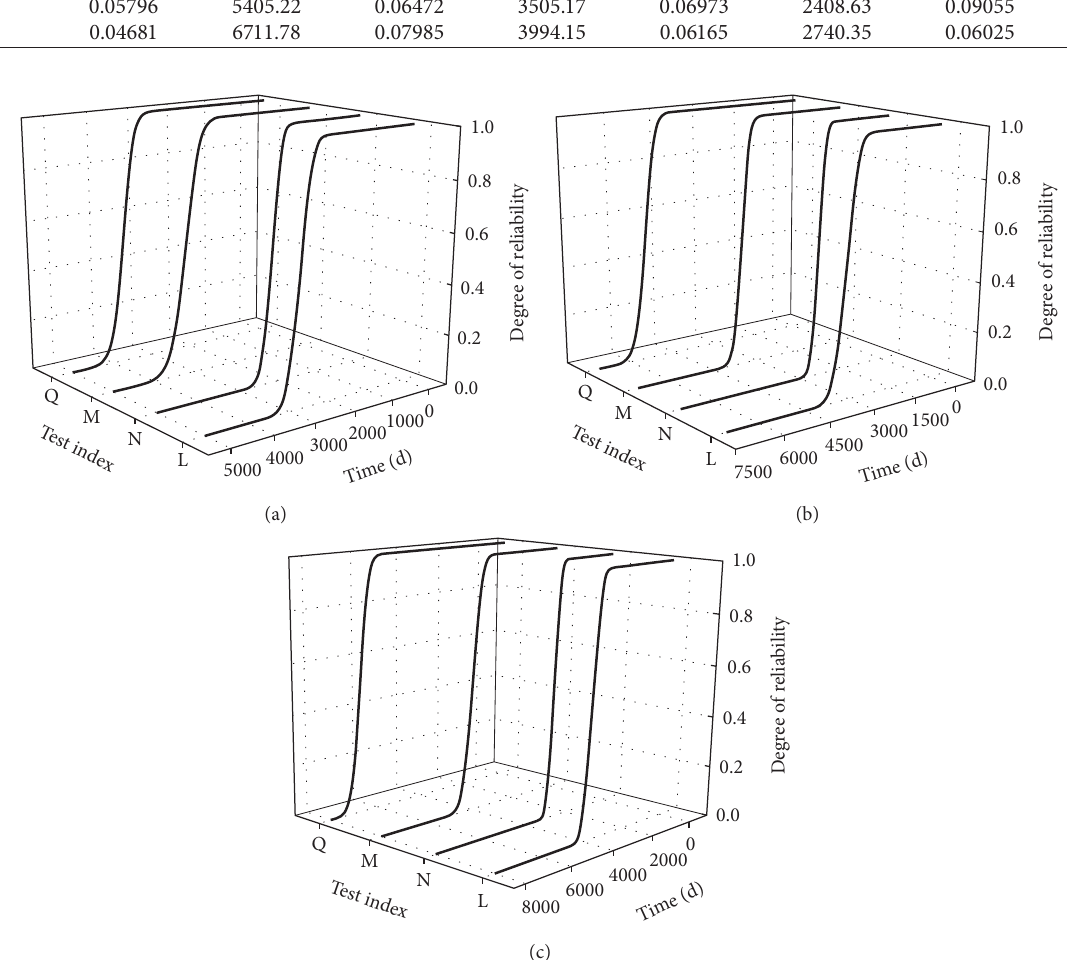
Figure 7: Life curve of different concrete. (a) C30 concrete. (b) C40 concrete. (c) C50 concrete.